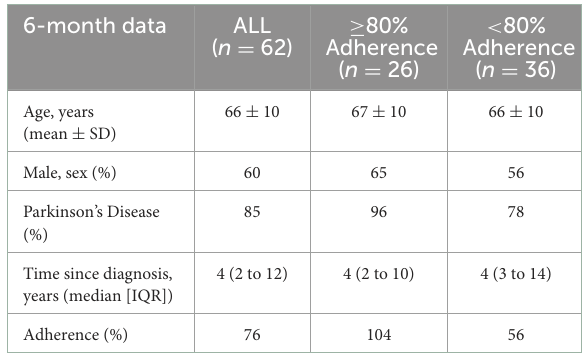
TABLE 1 Demographics and clinical characteristics of participants at